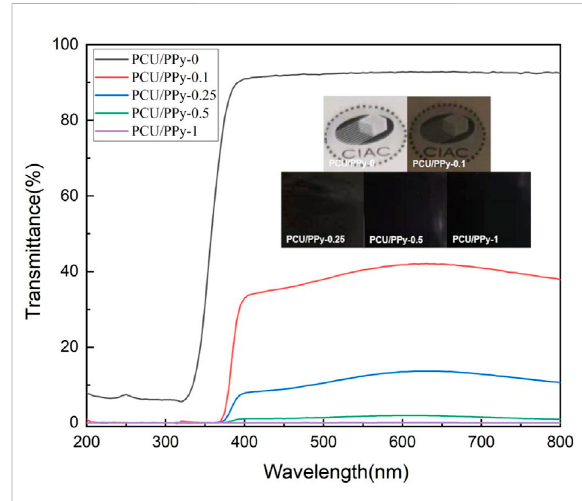
FIGURE 11 UV-vis light transmittance spectra of the PCU/PPy nanocomposites (Inserted is appearance of the PCU/PPy-x nanocomposites on the